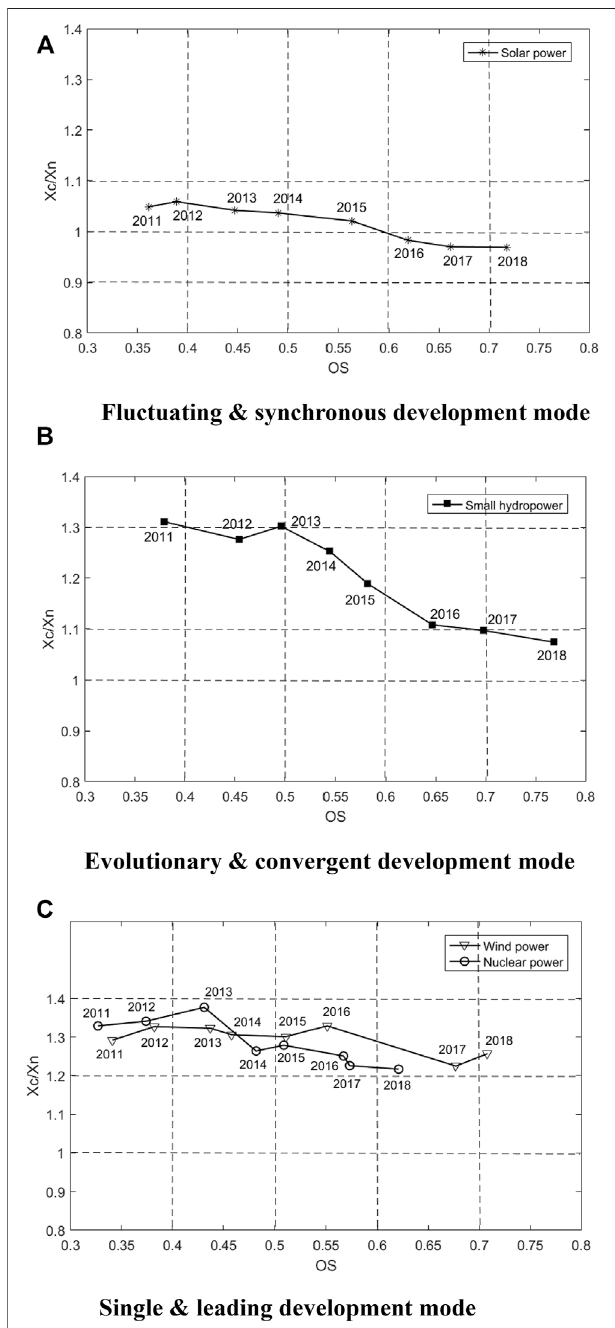
FIGURE 1 | Classi fi cation of the orderly synergistic development mode. (A) Fluctuating and synchronous development mode, (B) evolutionary and convergent development mode, and (C) single and leading development mode.